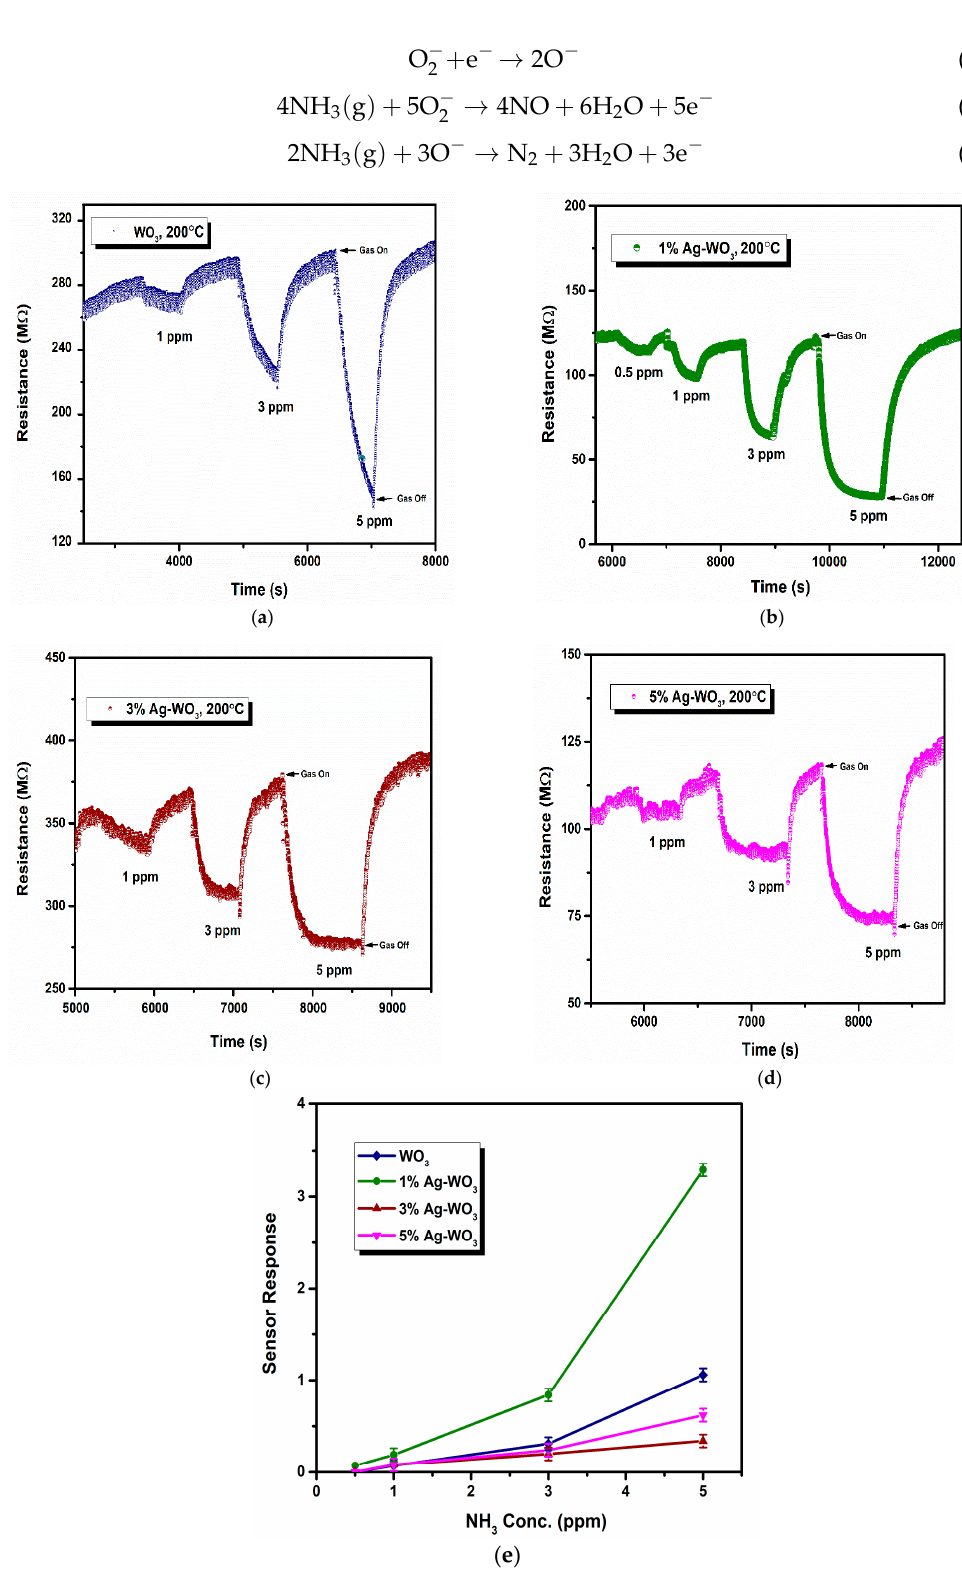
Figure 7. ( a – d ): Transient response curves of Ag–WO 3 films and ( e ) sensor response of the films at various NH 3 concentrations with error bars. Selectivity and repeatability are the key factors that decide the performance of the sensors. Figure 8 represents the bar graph elucidating sensor responses of WO 3 and 1% Ag–WO 3 films towards various gases. These films are tested at a 5-ppm concentration towards NH 3 , CO, CH 4, and NO 2 . Both films showed the highest response to NH 3 indicat- ing the selective nature of the deposited films towards ammonia among other gases. Re- peatability measurements of about 5 cycles were performed for both WO 3 and 1% Ag– WO